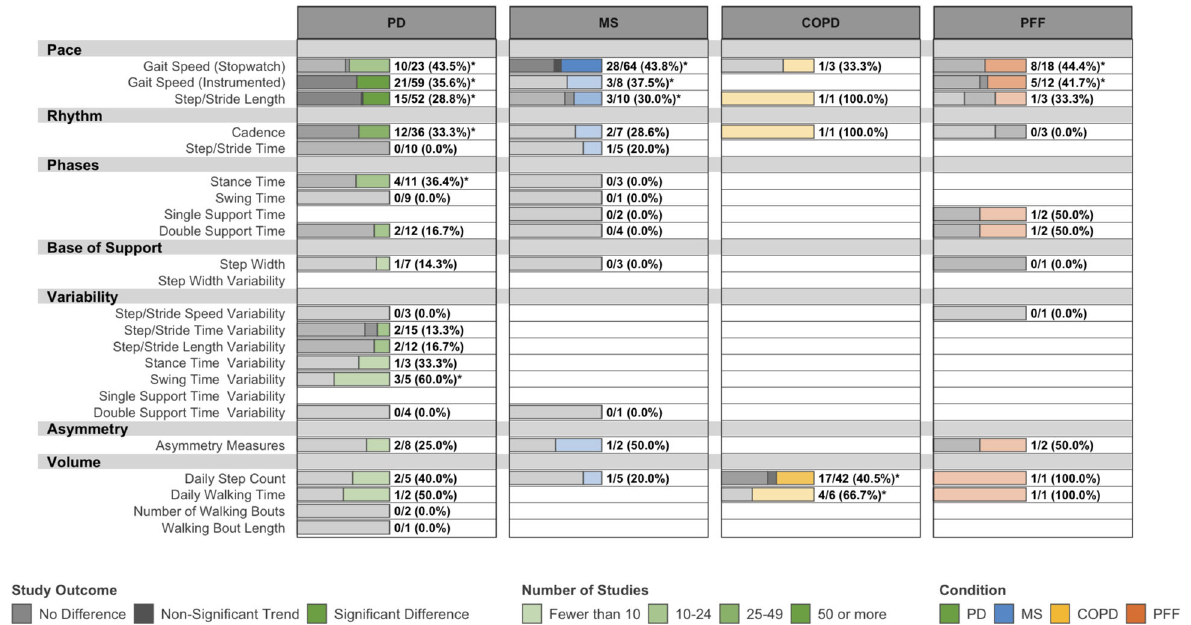
Fig. 5 Responsiveness of DMOs used as primary or secondary endpoints in all eligible interventional studies. PD Parkinson ’ s disease, MS multiple sclerosis, COPD chronic obstructive pulmonary disease, PFF proximal femoral fracture. Data are presented as: Number of studies with statistically signi fi cant differences between groups/Total studies (%). Interventions in eligible studies were not necessarily effective, and this map may underestimate the responsiveness of DMOs. DMOs known to be highly intercorrelated were grouped (i.e., step length and stride length), and all DMOs were organized according to previously established domains of gait. *Proportion of studies exceeds the expected false positive rate as determined by Bernoulli hypothesis testing and Benjamini – Hochberg